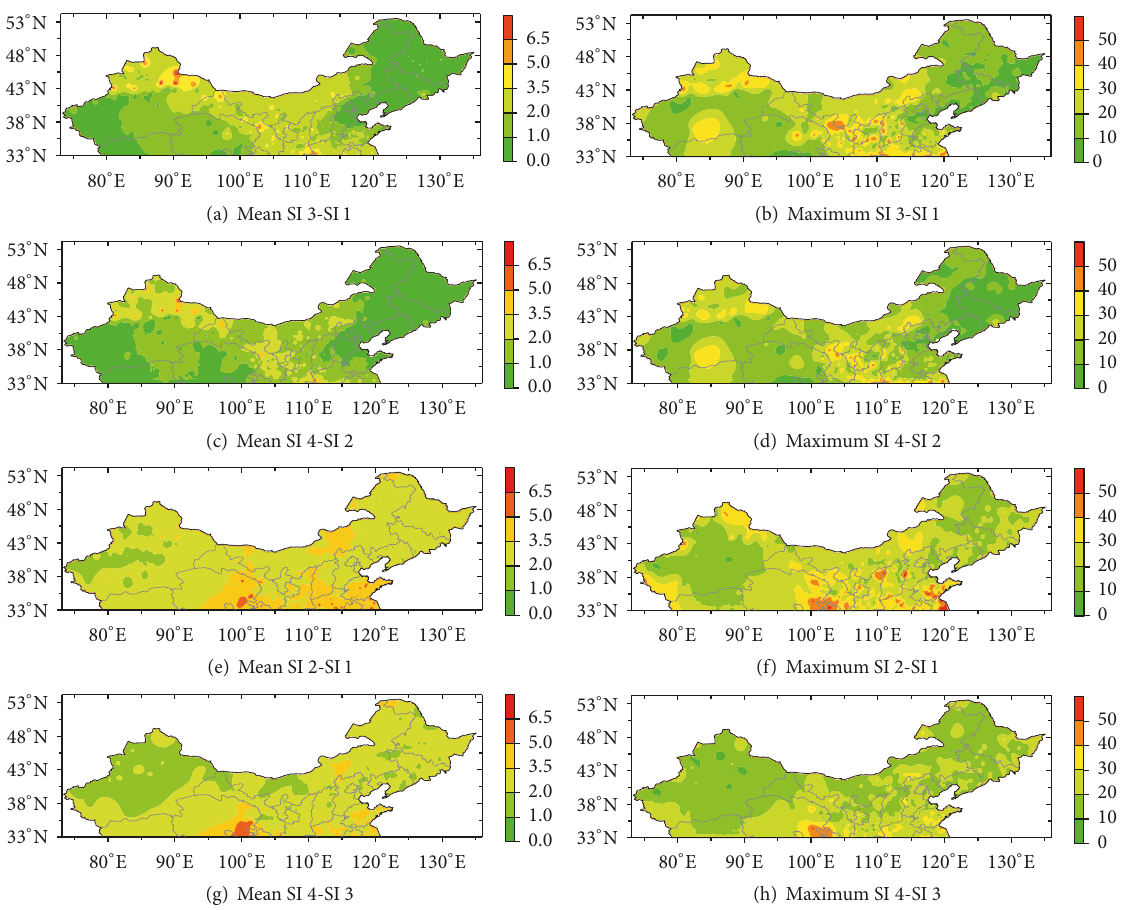
Figure 3: Differences (days) in the start of the growing season between selected indices in northern China. Shown are the mean values ((a), (c), (e), and (g)) and maximum values ((b), (d), (f), and